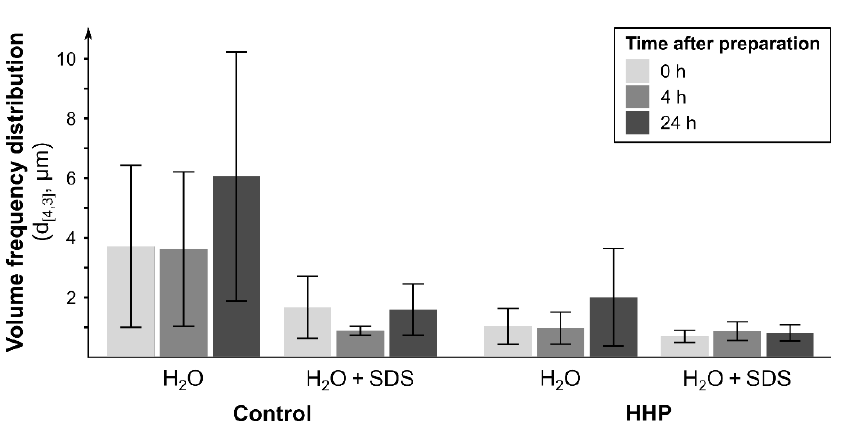
Figure 6. The volume frequency distribution (d [4,3] ) of emulsions from control UF-retentate and UF-retentate of plasma from pressure-treated granules 0 h, 4 h and 24 h after emulsion preparation (Tukey’s test, α = 0.05, n = 3, ±SD).